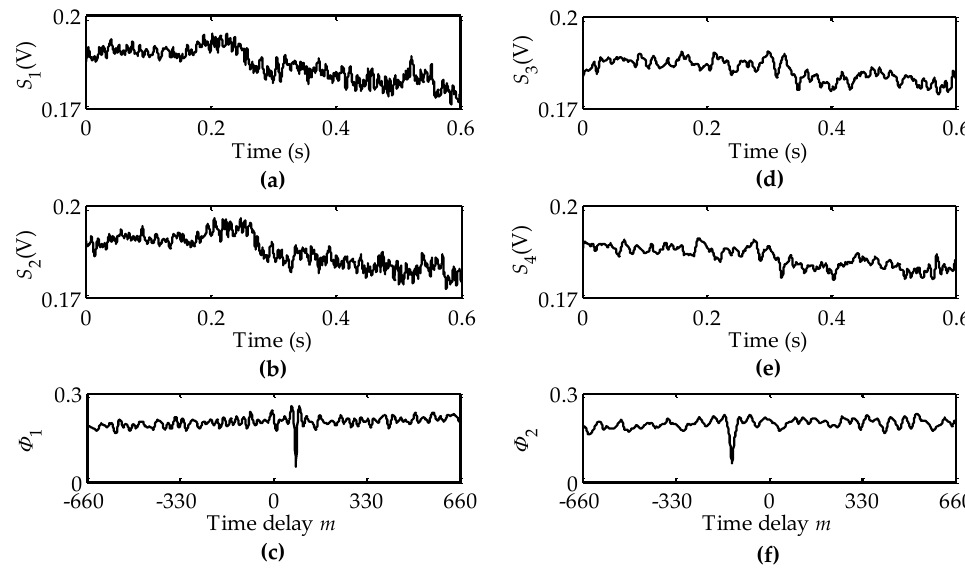
Figure 7. DSCs in the cases of clockwise rotation and the rotational center locating between the LVS1 and the LVS2: ( a , b , d , e ) are output signals of the QPD; ( c ) time delay between signals S 1 and S 2 ; ( f ) time delay between signals S 3 and S 4 .